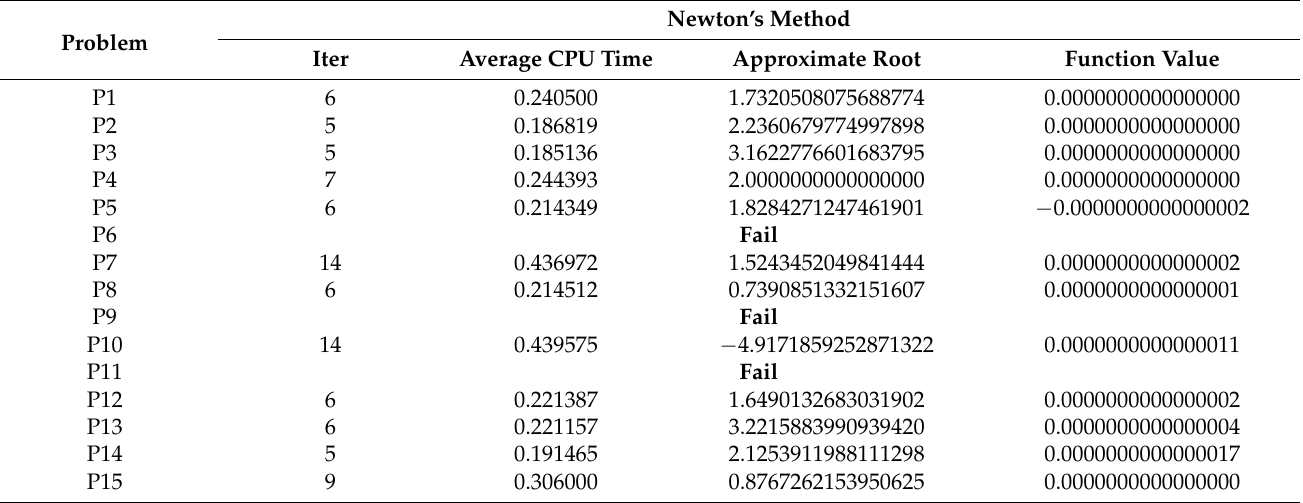
Table 6. Solutions of fifteen problems by Newton’s